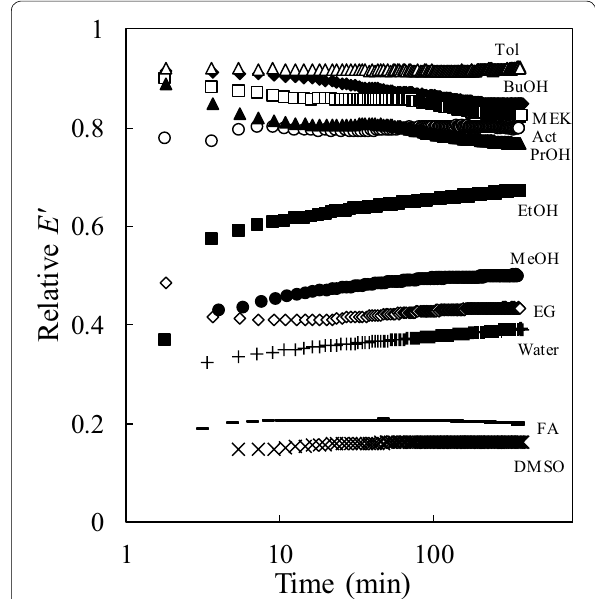
Fig. 7 Change in the relative E’ of the untreated sample after soaking in water or each organic liquid. The relative E’ was relative to the value for untreated sample in oven‑dried